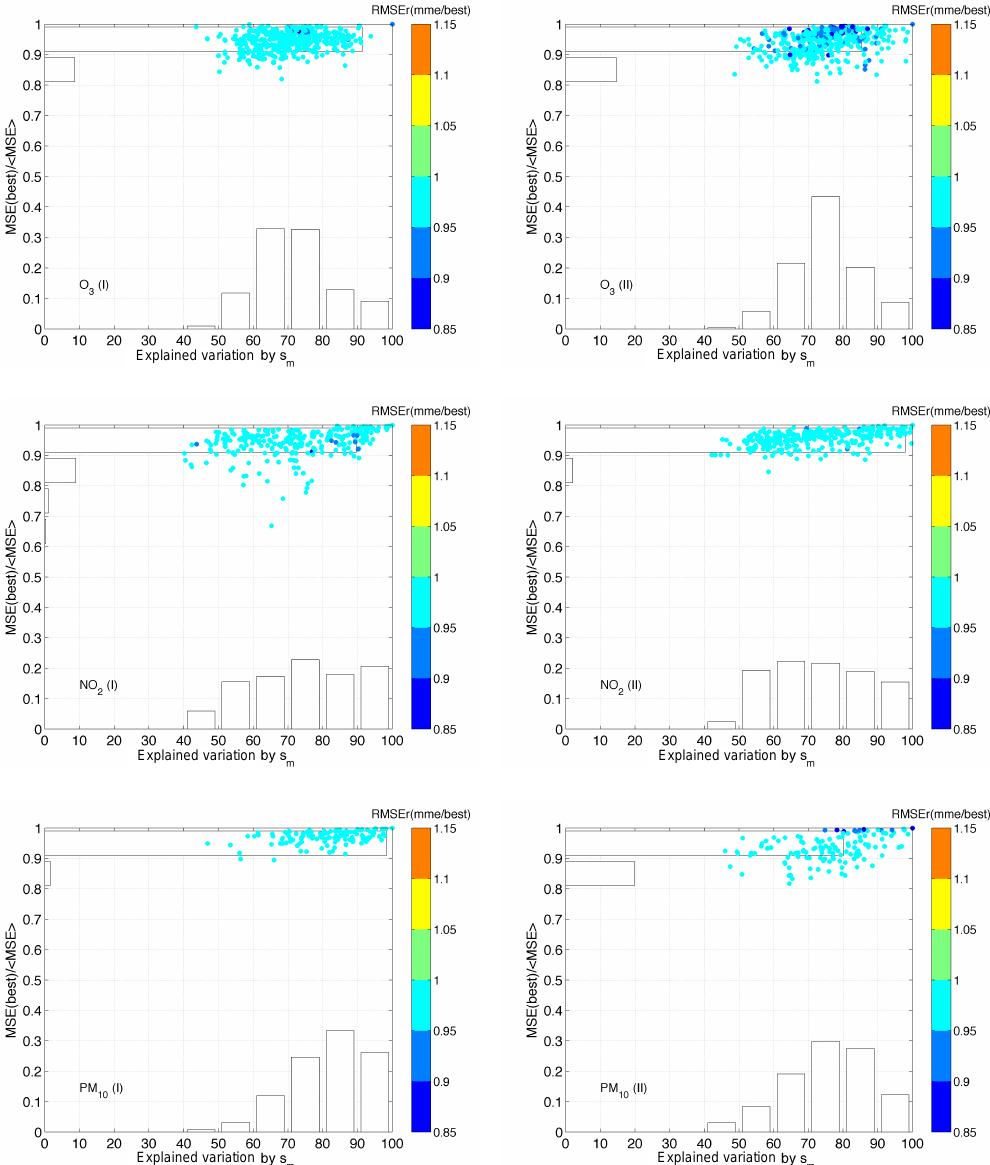
Figure 8. Like Fig. 5 but for the mme < skill in the reduced ensemble. Please note the change in the colour